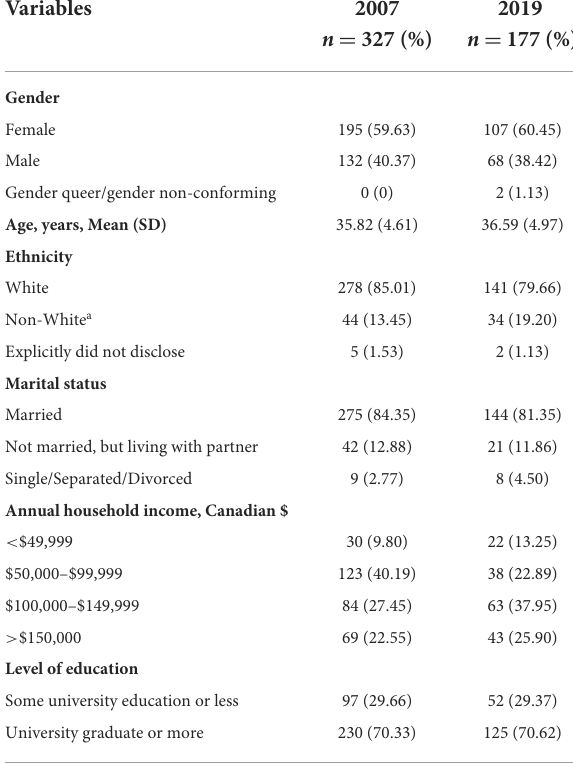
TABLE 1 Characteristics of the parents who responded to questions about the 2007 CFG ( n = 327) and the 2019 CFG ( n = 177).